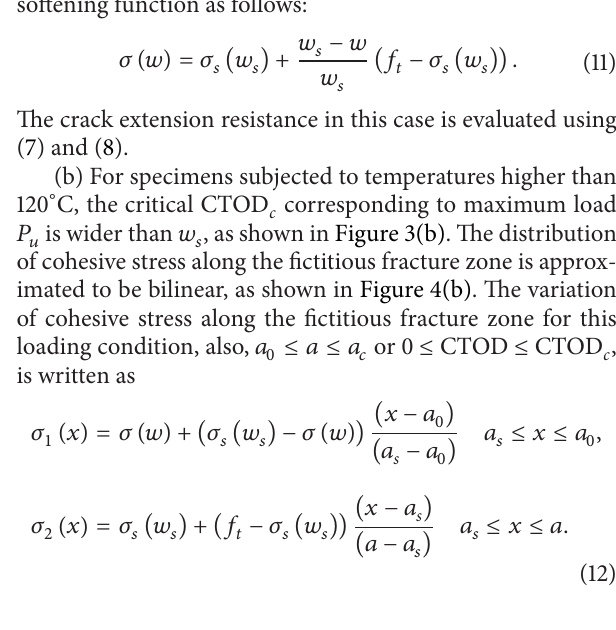
Figure 4: The cohesive distribution of crack propagation stage